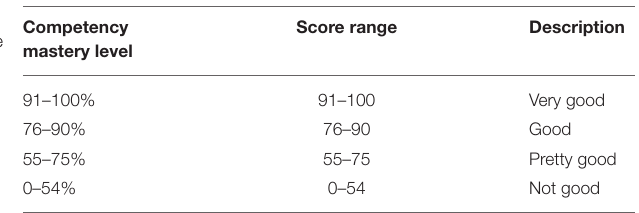
TABLE 6 | Success criteria.